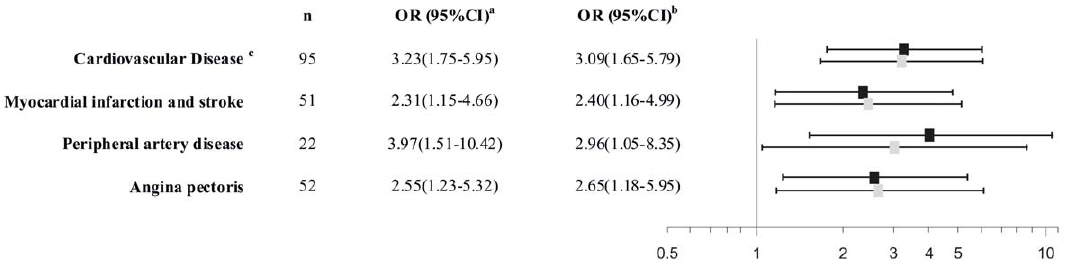
Figure 3. Logistic regression analysis of PTX3 level on prevalent vascular diseases. Odds ratios (OR) and 95% confidence intervals (CI) were calculated per 1 unit increase in log-transformed PTX3. Black squares denote ORs adjusted for sex and age, gray squares mark ORs adjusted for age, sex, HDL, LDL-cholesterol, smoking, diabetes, hypertension, body mass index and waist circumference. a adjusted for age and sex. b adjusted for age, sex, HDL, LDL-cholesterol, smoking, diabetes, hypertension, body mass index and waist circumference. c composite endpoint of stroke, TIA, myocardial infarction, peripheral artery disease, definite angina and previous revascularization procedures.